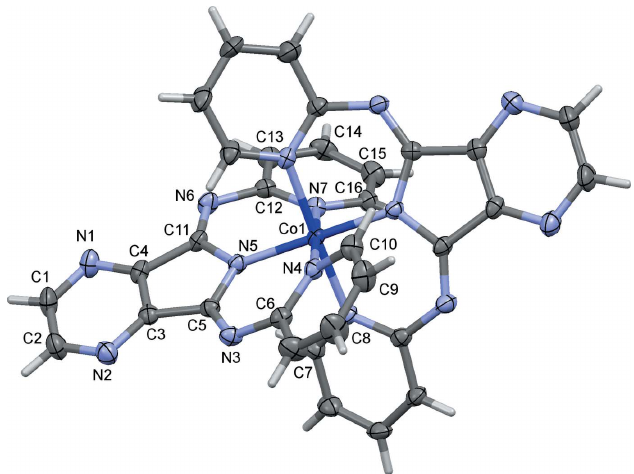
Figure 1 The molecular structure of the cation of the title complex, with atom labelling and displacement ellipsoids drawn at the 50% probability level. Unlabelled atoms are related to labelled atoms by the twofold